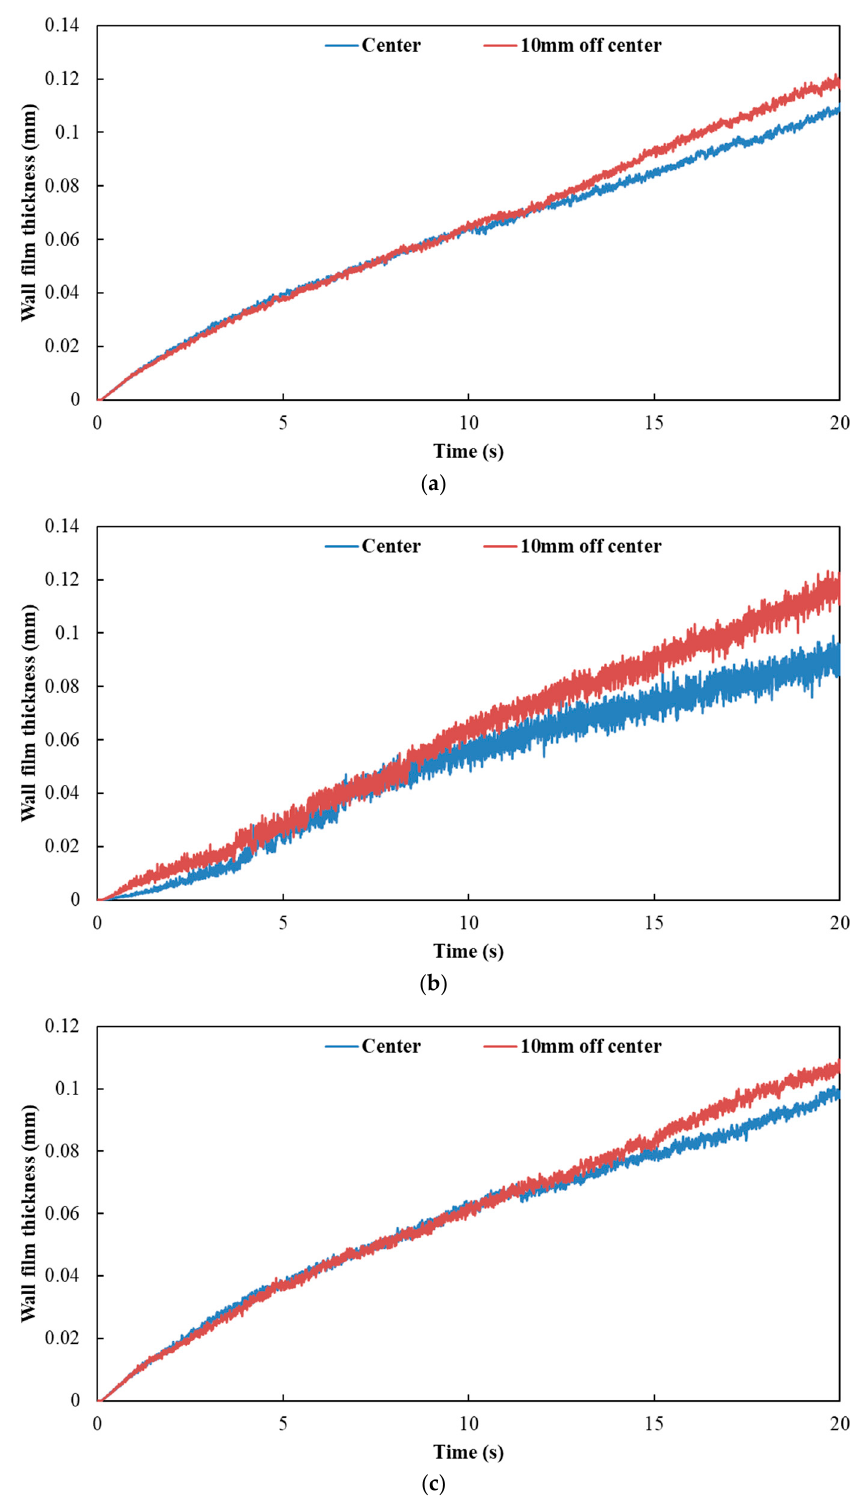
Figure 16. In fl uence of di ff erent nozzle positions on wall fi lm thickness. ( a ) Case 1; ( b ) Case 2; ( c ) Case